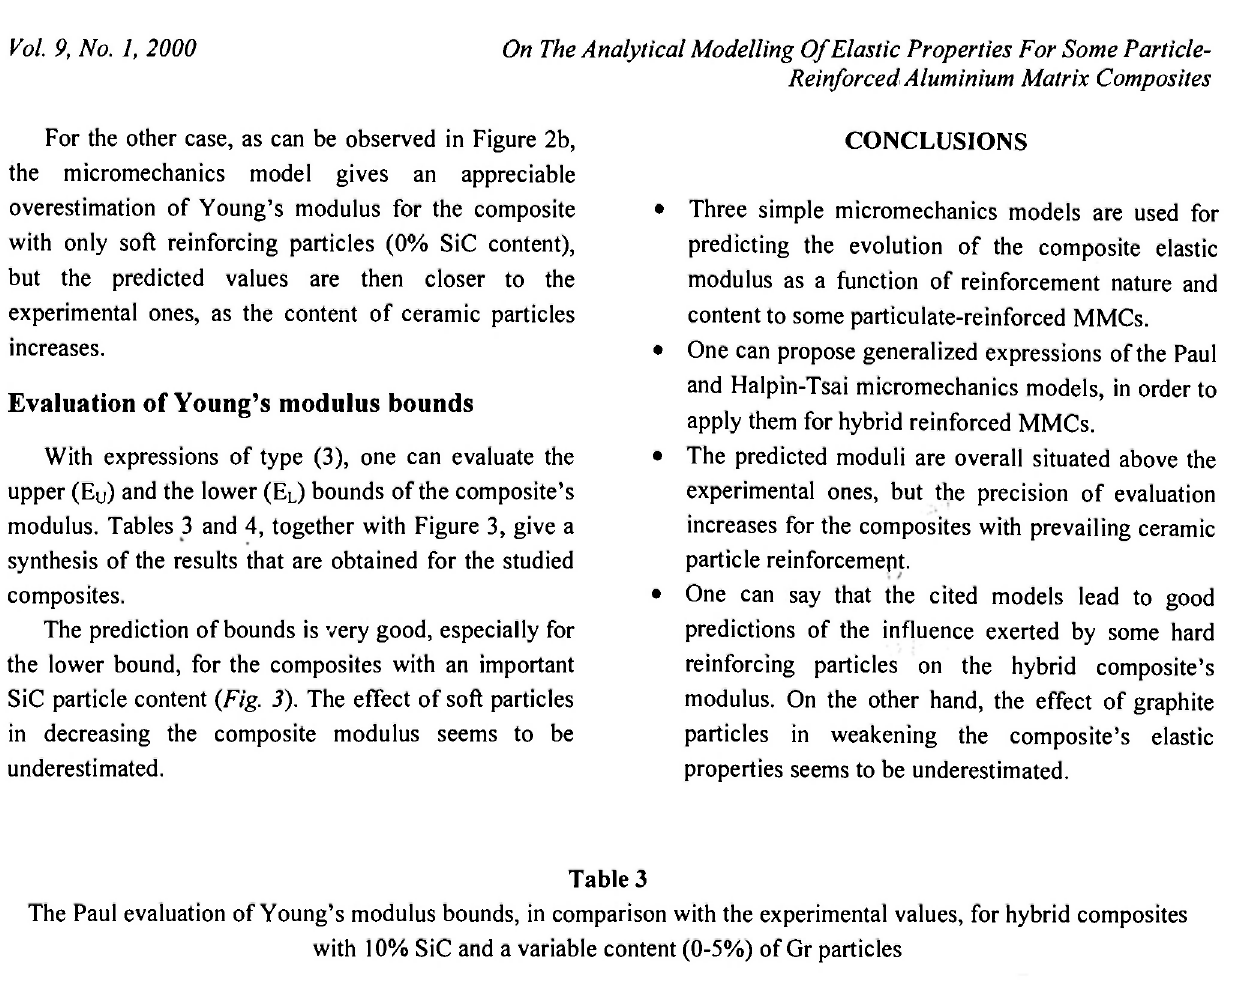
The Paul evaluation of Young's modulus bounds, in comparison with the experimental values, for hybrid composites with 10% SiC and a variable content (0-5%) of Gr particles